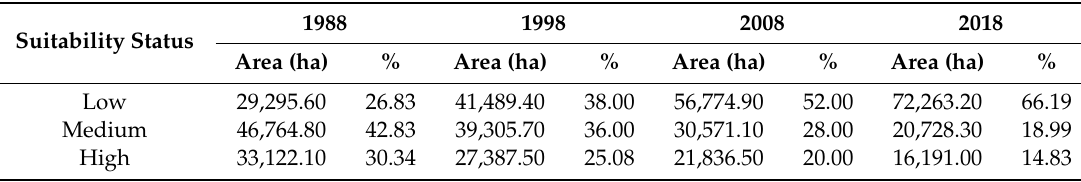
Table 10. Trends of habitat suitability